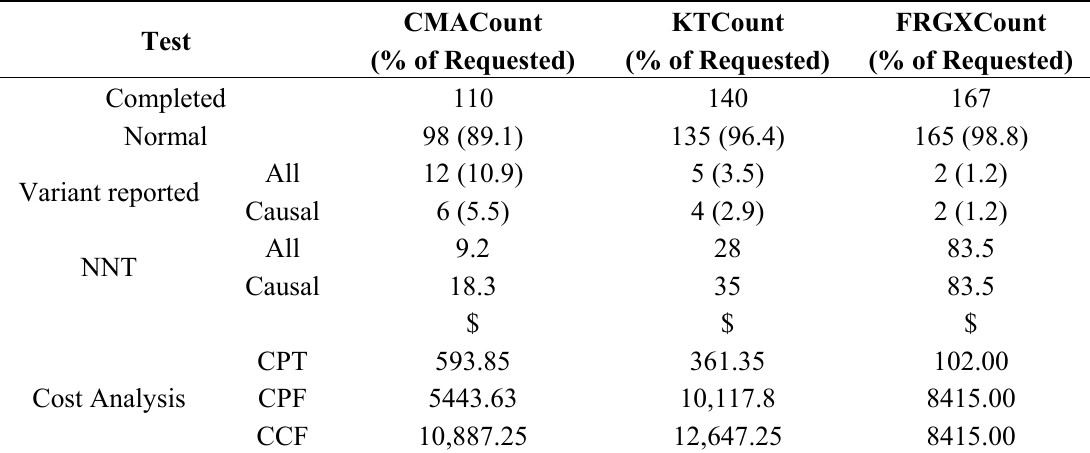
Table 1. Yield and cost of testing in 698 patients with pervasive developmental disorder. CMACount KTCount FRGXCount Test (% of Requested) (% of Requested) (% of Requested) 110 140 98